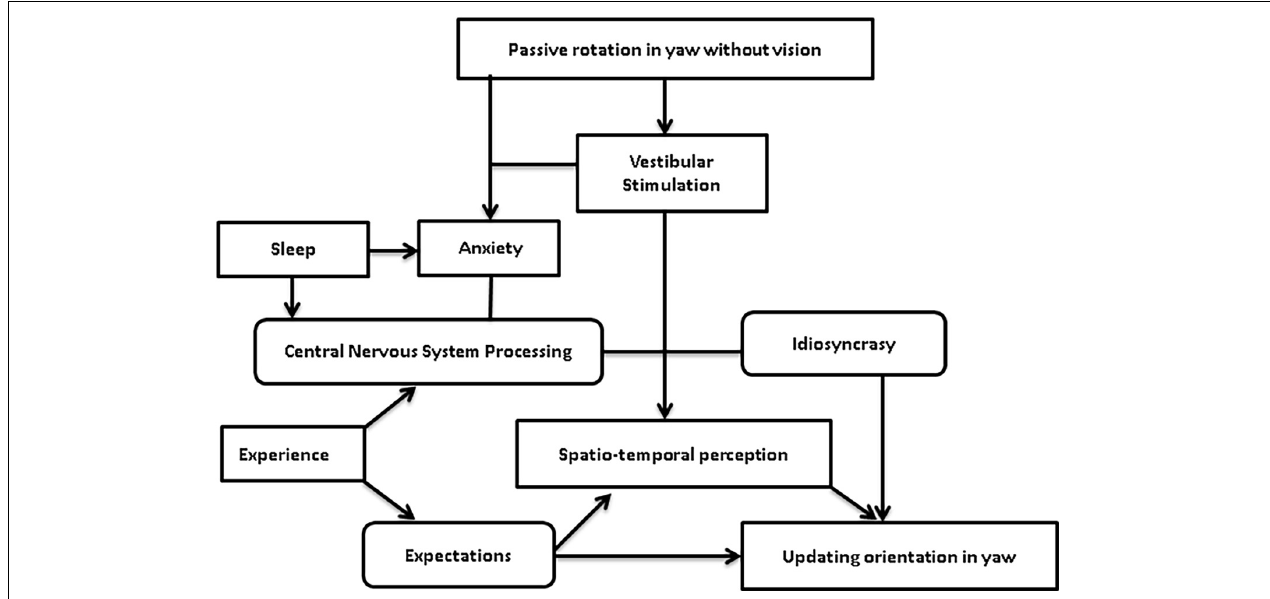
FIGURE 2 | Theoretical model of the interaction among individual factors during passive rotation without vision to update orientation in the horizontal